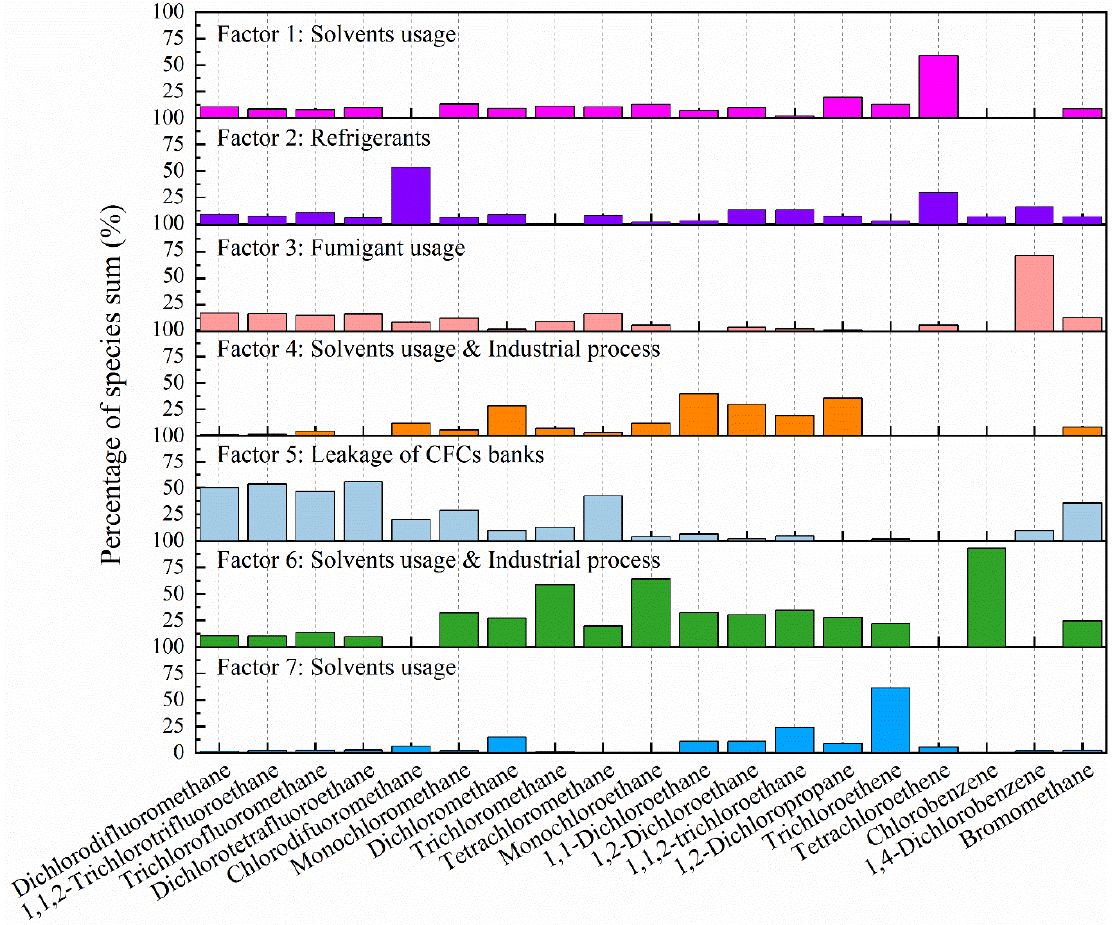
Figure 9. Main sources of volatile halogenated hydrocarbons in ambient air in the study area and the contributions of individual compounds.